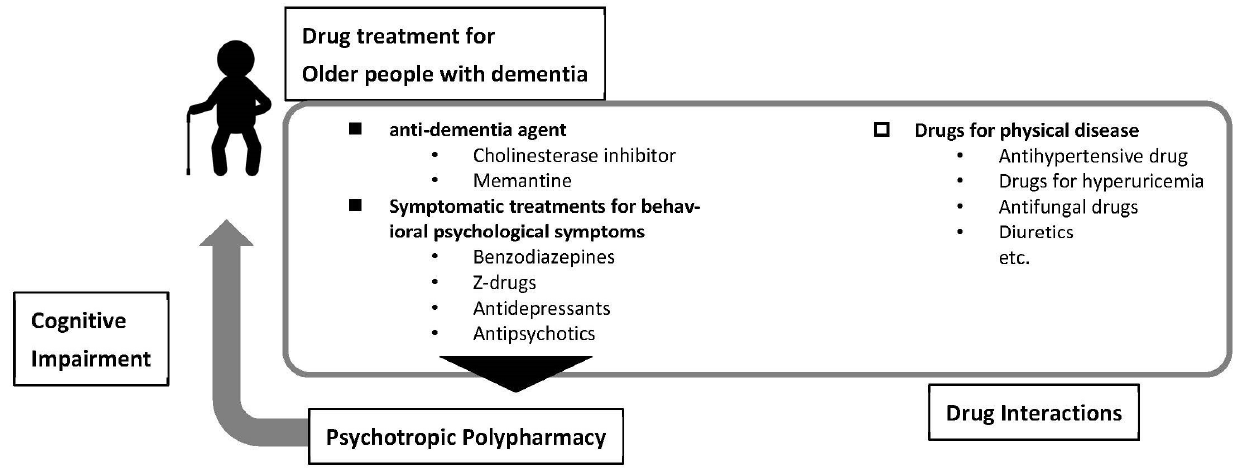
Figure 2. Summary of contents in this review.